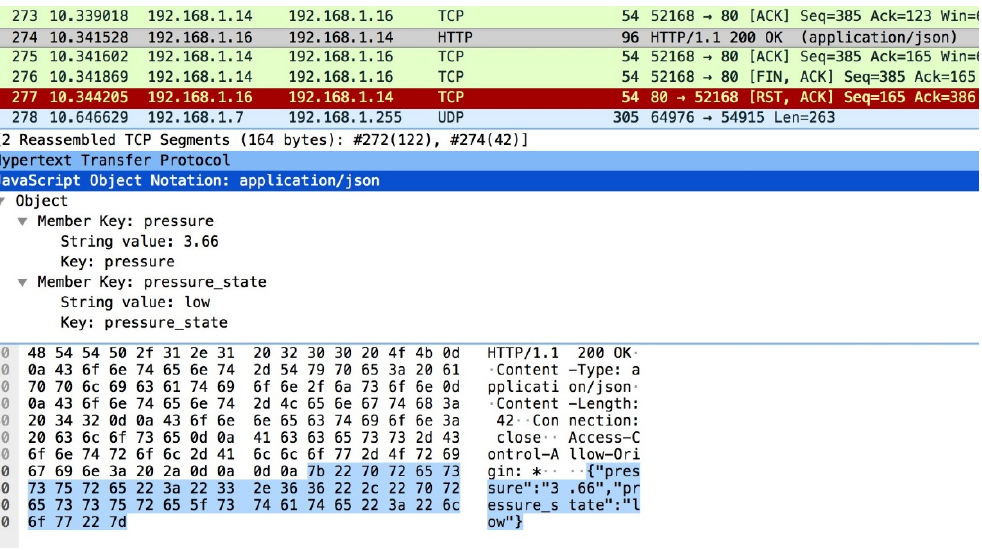
Figure 12. Capture adversarial sensor values under attack scenario.